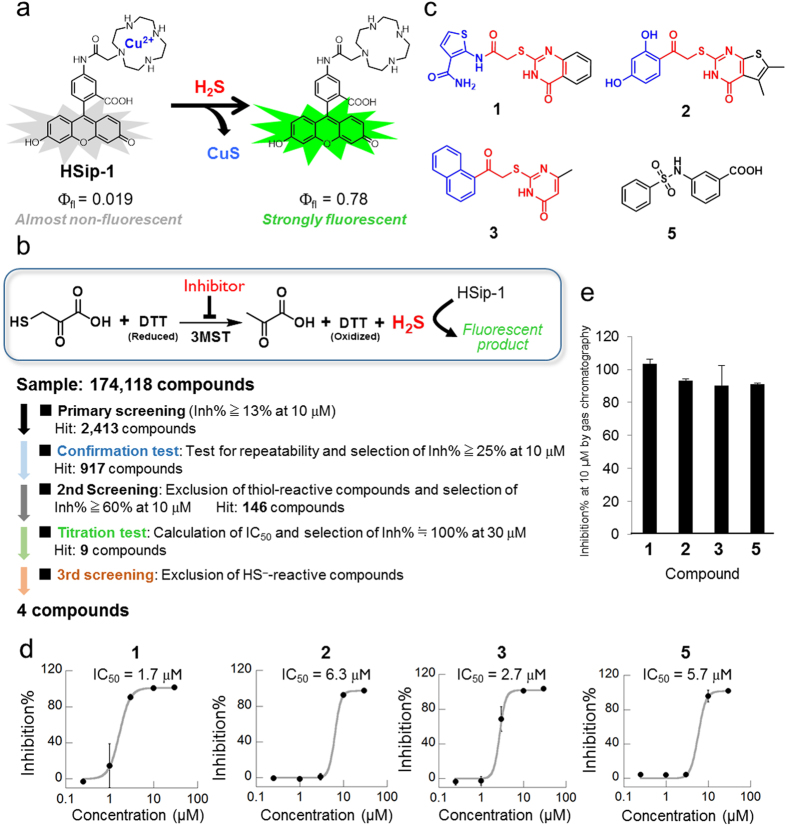
HTS scheme and hit compounds.(a) The fluorescent probe for H2S, HSip-1, and its fluorescence off/on mechanism in response to H2S. (b) Detection system of 3MST enzymatic activity with HSip-1 and the scheme for HTS of a chemical library of 174,118 compounds. (c) The chemical structures of 4 potential inhibitors (hit compounds) for 3MST. (d) Dose-response curves of inhibitory activity of compounds 1, 2, 3 and 5 towards 3MST in the titration test. (e) Inhibitory activity of hit compounds at 10 μM measured by gas chromatography.